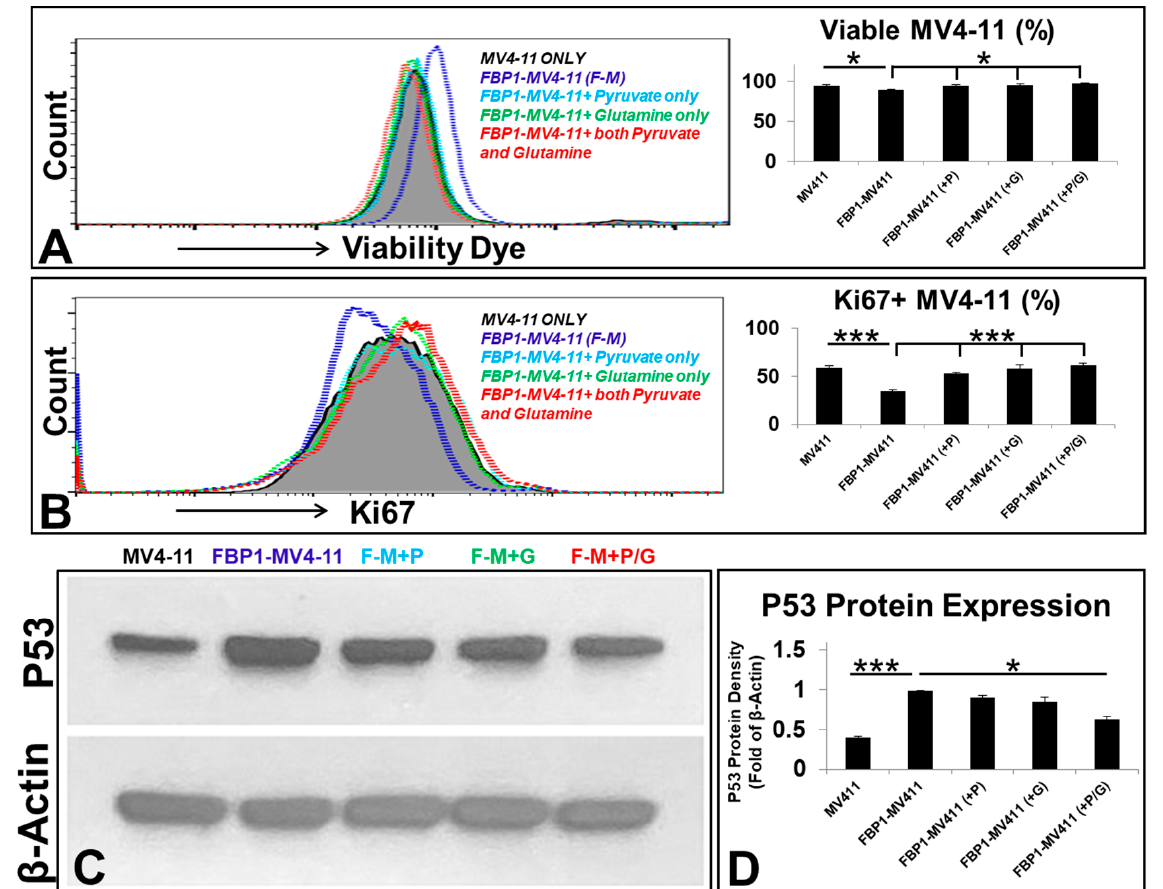
Figure 3. The reduced proliferation of FBP1-MV4-11 cells could be rescued by supplementation of pyruvate and/or glutamine in vitro: ( A ) A representative FC histogram showing the expression of viability dye (more expression representing more cell death) in different FBP1-MV4-11 rescue cell lines in vitro, including naïve MV4-11, FBP1-MV4-11 cells, FBP1-MV4-11 cells with supplementation of pyruvate, FBP1-MV4-11 cells with supplementation of glutamine, and FBP1-MV4-11 cells with supplementation of both pyruvate and glutamine; details of pyruvate and glutamine dosages and culture conditions are described in the Materials and Methods; Right panel: Cumulative FC percentage data of viable blasts in different experimental groups from ( A ). ( B ) A representative FC histogram showing Ki67 expression in different FBP1-MV4-11 rescue cell lines in vitro; Right panel: Cumulative FC percentage data of Ki67+ expression in different experimental groups from ( B ). ( C ) A representative film showing WB assay of human P53 protein expression in different experimental groups from ( A ). ( D ) Cumulative WB data of human P53 expression in different experimental groups from ( C ). Where applicable, data are means ± SEM and were analyzed by Student’s “ t ”-test; * p < 0.05, *** p < 0.005, n = 3.